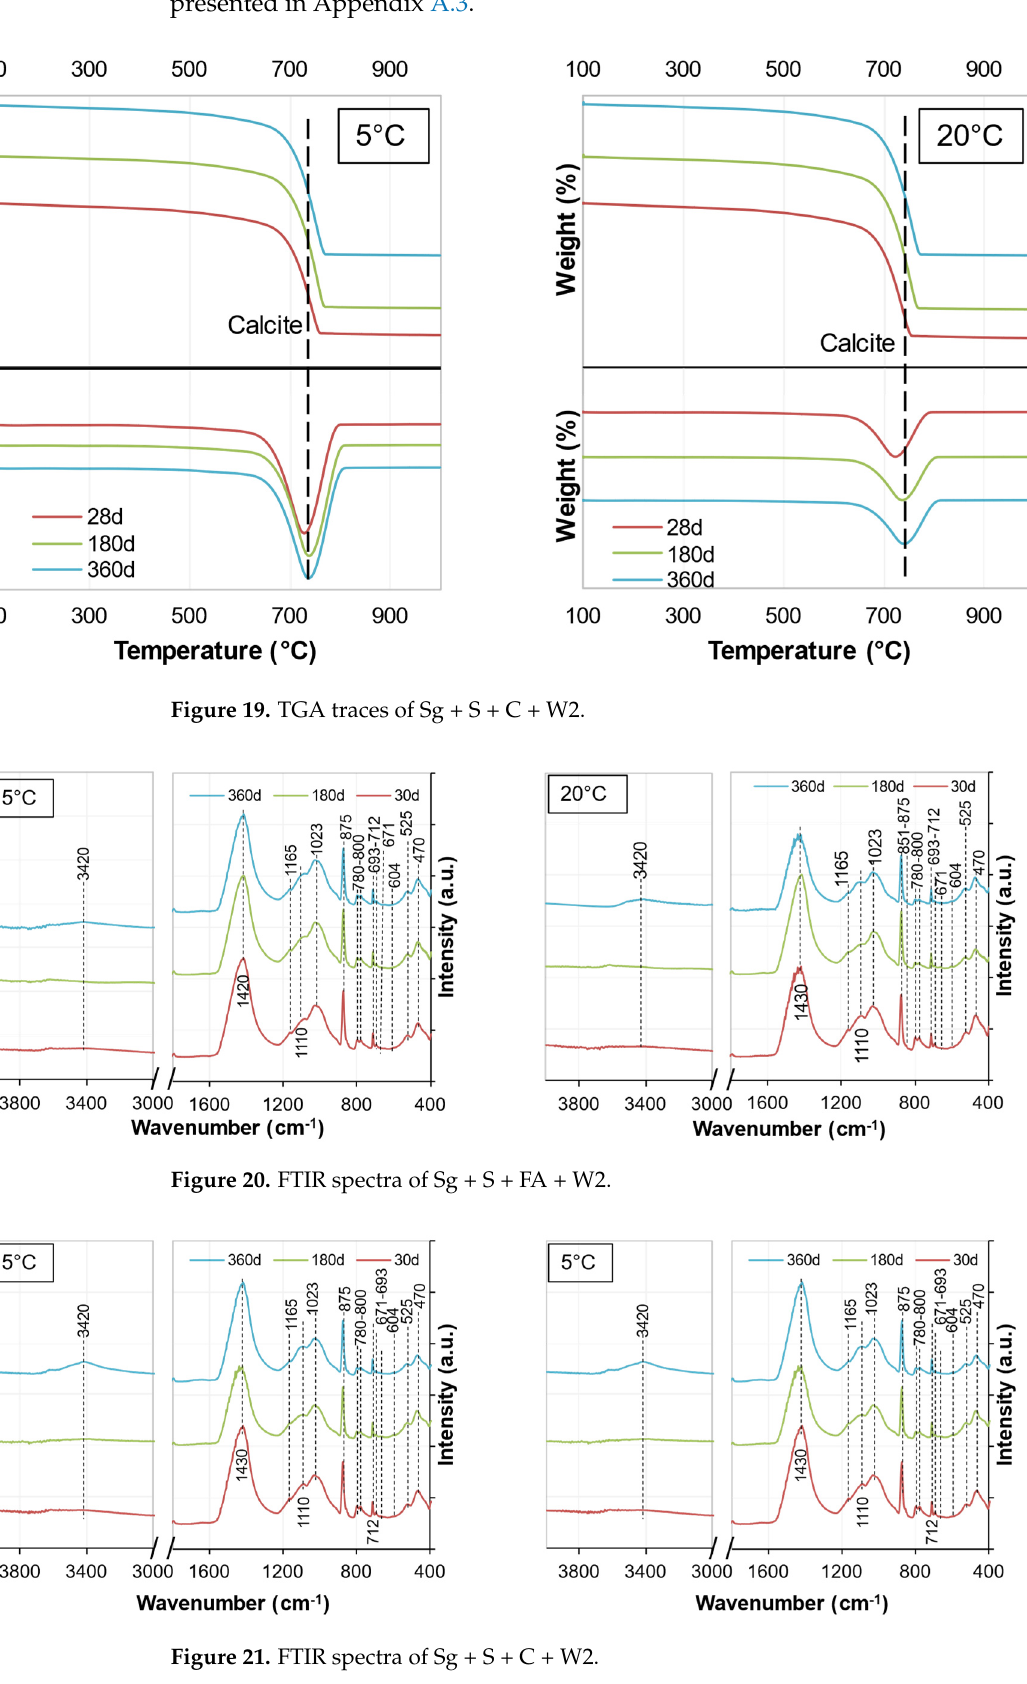
Figure 18. TGA traces of Sg + S + F + W2.